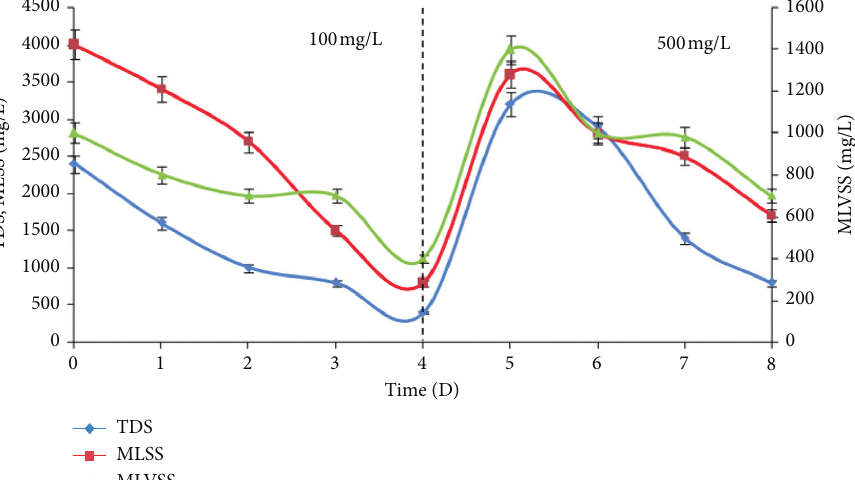
Figure 9: Removal of TDS, MLSS, and MLVSS in the sequential anaerobic-aerobic treatment processes carried out in the An-SBR and aerobic